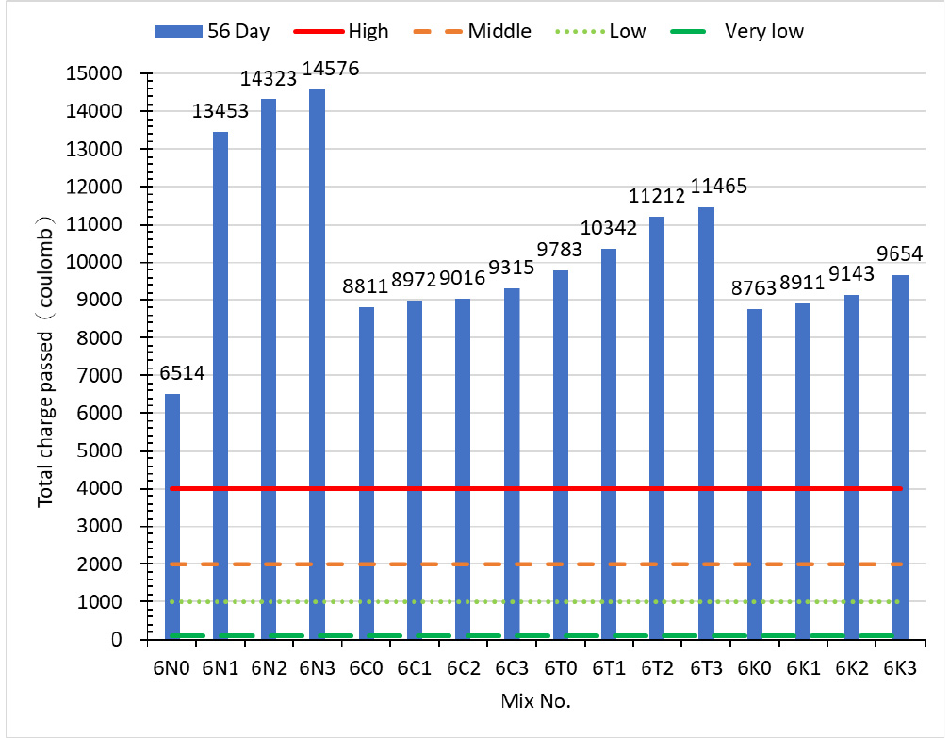
Figure 13. Chloride charge flux of cement mortar when W/C = 0.6.